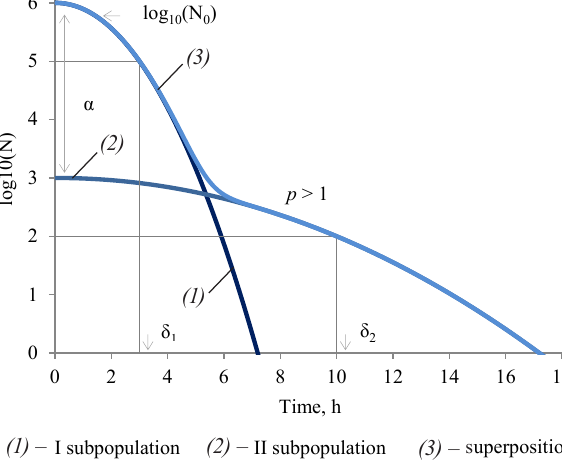
II Figure 2 Graphical interpretation of the subpopulation approach to the microbial death kinetics during heat treatment (adapted from [36])